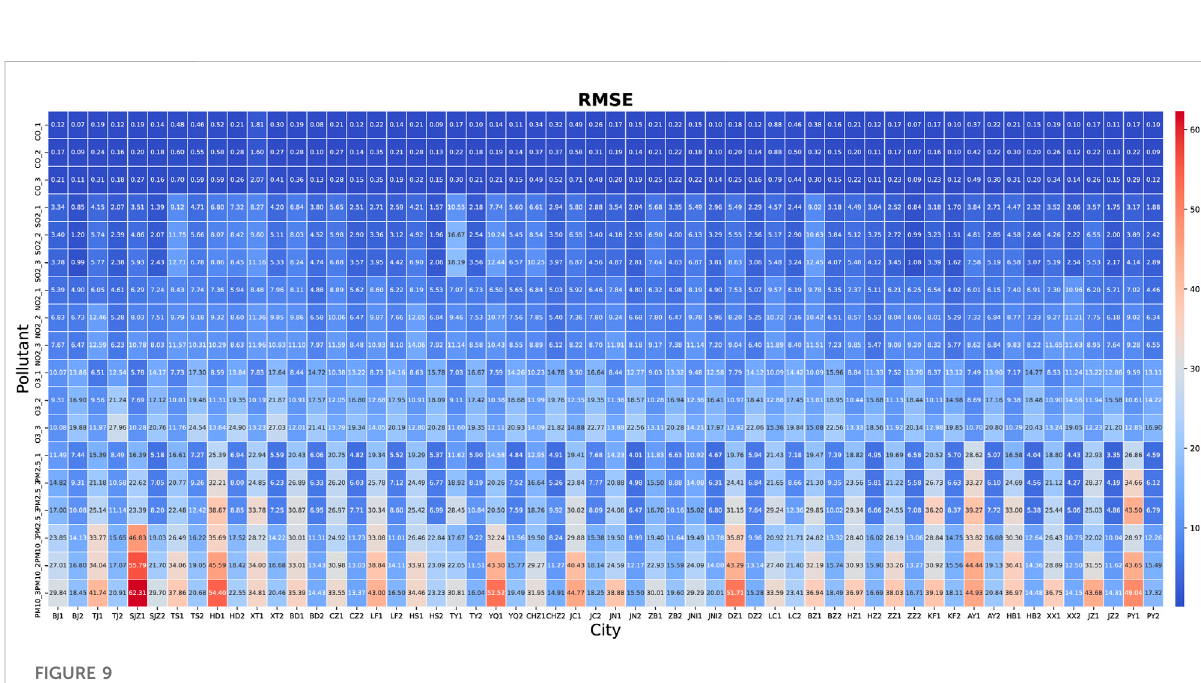
lower. According to all results, the number of positive values is equal to that of negative values. Generally, the NMB does not show obvious correlation with city, pollutant, prediction step and test set, and there is no systematical deviation shown by these experiments.